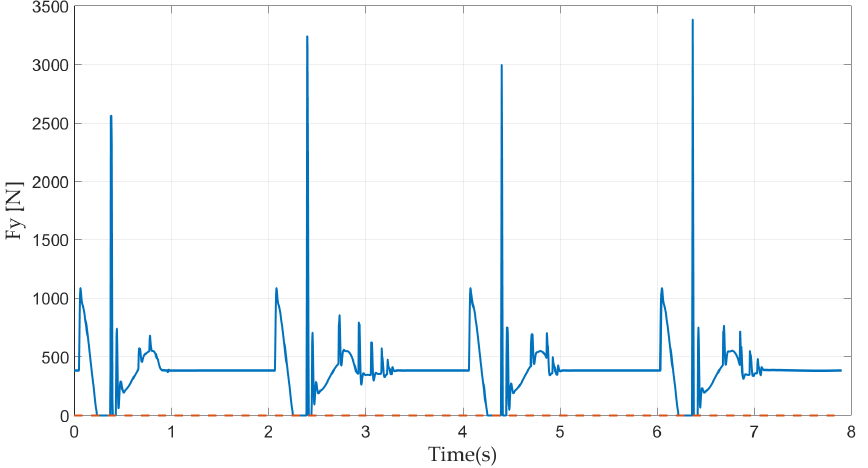
Figure 9. Ground reaction force.